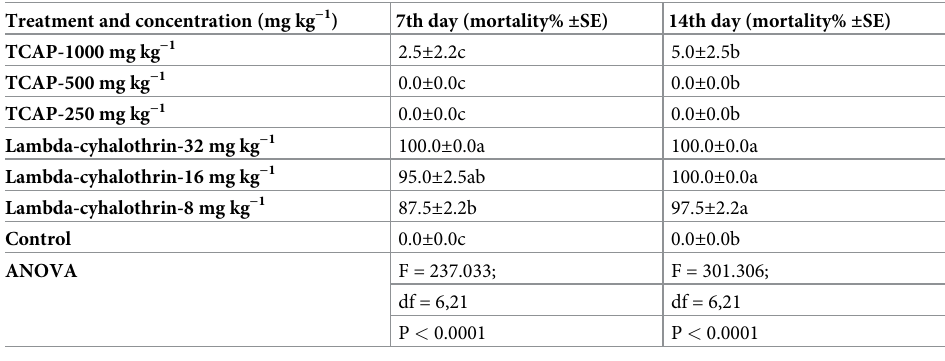
decreased in the LC and LC TCAP groups, which was consistent with the finding of Lai and 10 30 Su that sublethal concentrations of chlorantraniliprole suppressed S . exigua fecundity [35], indi- cating that TCAP is an effective alternative tool for S . exigua management. Studies have shown that sublethal concentrations of some insecticides induce fecundity- stimulating effects and result in a resurgence of the insect pest population. For example, suble- thal doses of imidacloprid and azadirachtin stimulated the reproduction of green peach aphids, and sublethal doses of triazofos and pyrethroids contributed to the enhanced fecundity of brown planthoppers [36, 37]. In contrast, this study revealed that the fecundity of S . exigua treated with sublethal concentrations of TCAP was significantly reduced compared to the con- trol level. It seems that the LC of TCAP disrupted the energy homeostasis and prolonged the 10 larval stage of S . exigua , contributing to larvae shifting energy from growth to detoxification metabolism [38]. Likewise, the LC of TCAP retarded the growth of S . exigua with a pro- 30 longed TPOP. These results illustrated that a sublethal concentration of TCAP did not induce resurgence in the S . exigua population. The age-stage, two-sex life table theory can be to evaluate of the effect of insecticides on insect populations. The life table parameters can be used to assess the sublethal effects of insec- ticides at the population level [39, 40]. The population parameters, such as γ , λ , and R sub- 0 , stantially declined in the LC and LC groups compared with those in the control group, 10 30 suggesting that sublethal TCAP concentrations inhibited the growth rate and reproduction of Table 4. Toxicity of TCAP against E . fetida earthworms.